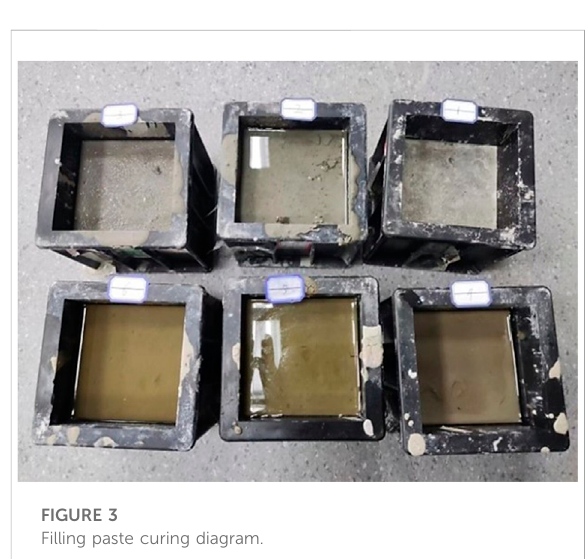
FIGURE 3 Filling paste curing